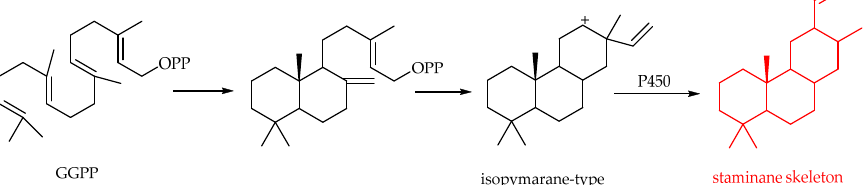
Figure 68. Structure of anemhupehin A 164 [107].